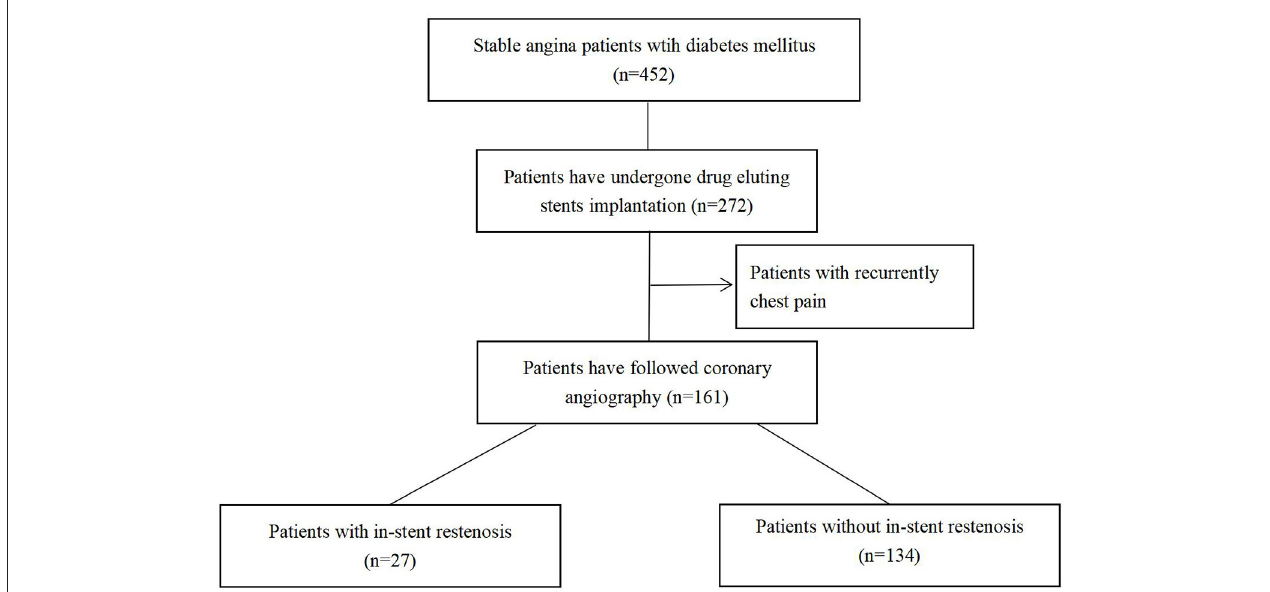
FIGURE 1 | Study flowchart. A total of 161 patients finally enrolled in our